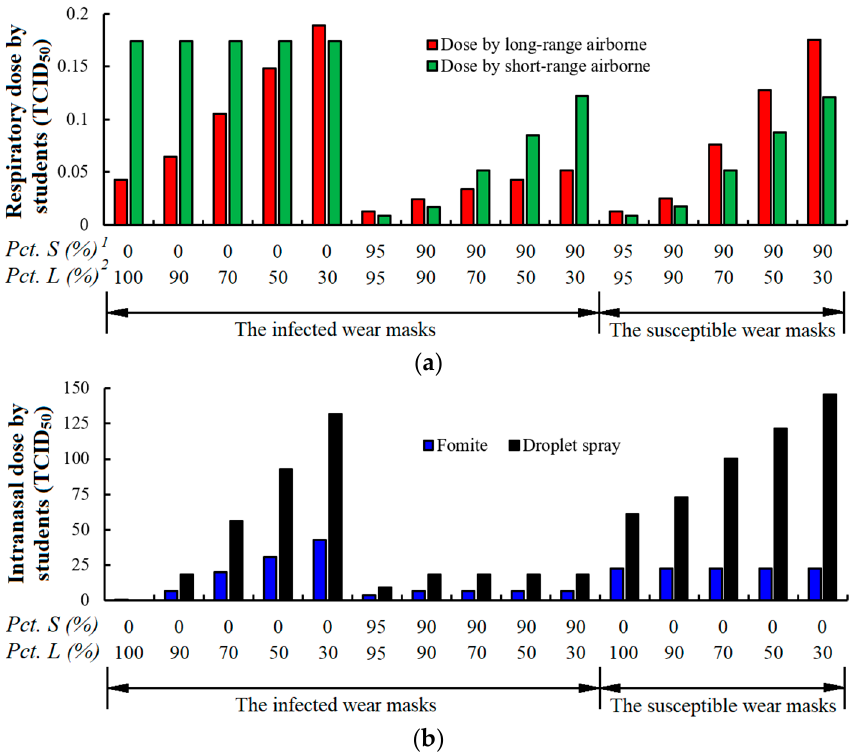
Figure 6. Dose of influenza A virus by susceptible students under different mask wearing strategies and efficiencies. ( a ) Long ‐ range and short ‐ range airborne routes; ( b ) fomite and droplet spray routes. 1 Pct.S (%): Percentage of small particles blocked by masks. 2 Pct.L (%): Percentage of large droplets blocked by masks.